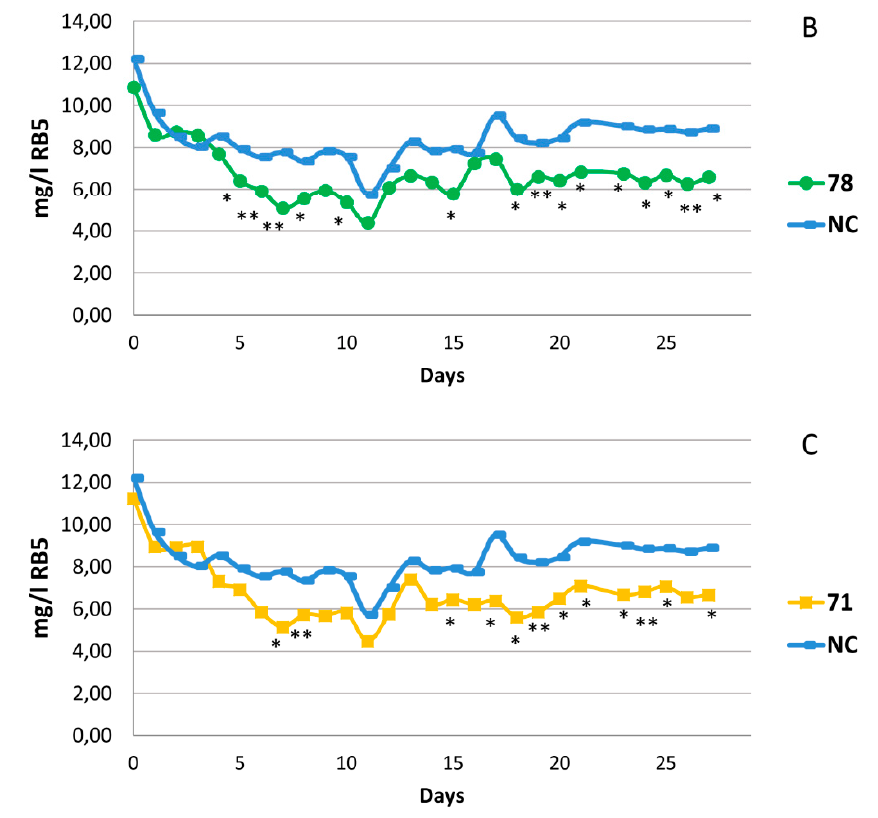
Figure 6. Concentration of RB5 daily measured from microcosm effluents over the experimental period (27 days). Values are reported as a means of the replicated CW microcosms (n = 3). RB5 concentration was compared between ( A ) NC = negative control, non-bacterized J. acutus plants, and plant inoculated using a consortium of the six isolates (mix); ( B ) NC and plants inoculated with 78 = E. ludwigii CWMP-8R78; ( C ) NC and plants inoculated with 71 = F. jonhsoniae CWMP-8R71. The stars indicate the days were statistically significant differences were observed (* p < 0.05, ** 0.001 < p < 0.01, *** p < 0.001).